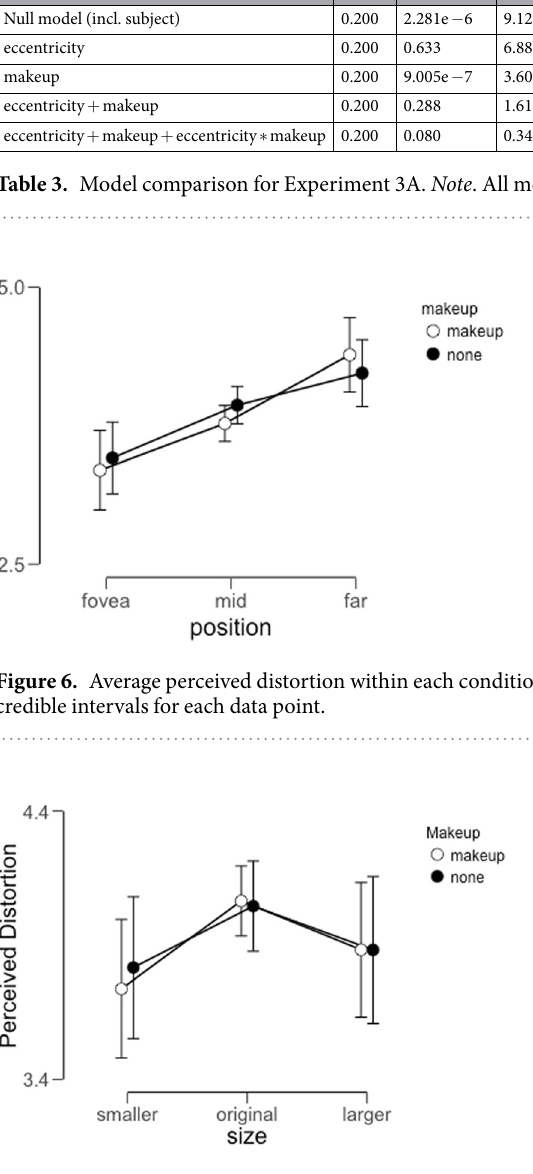
Figure 7. Average perceived distortion within each condition for Experiment 3B. Error bars represent 95% credible intervals for each data point.